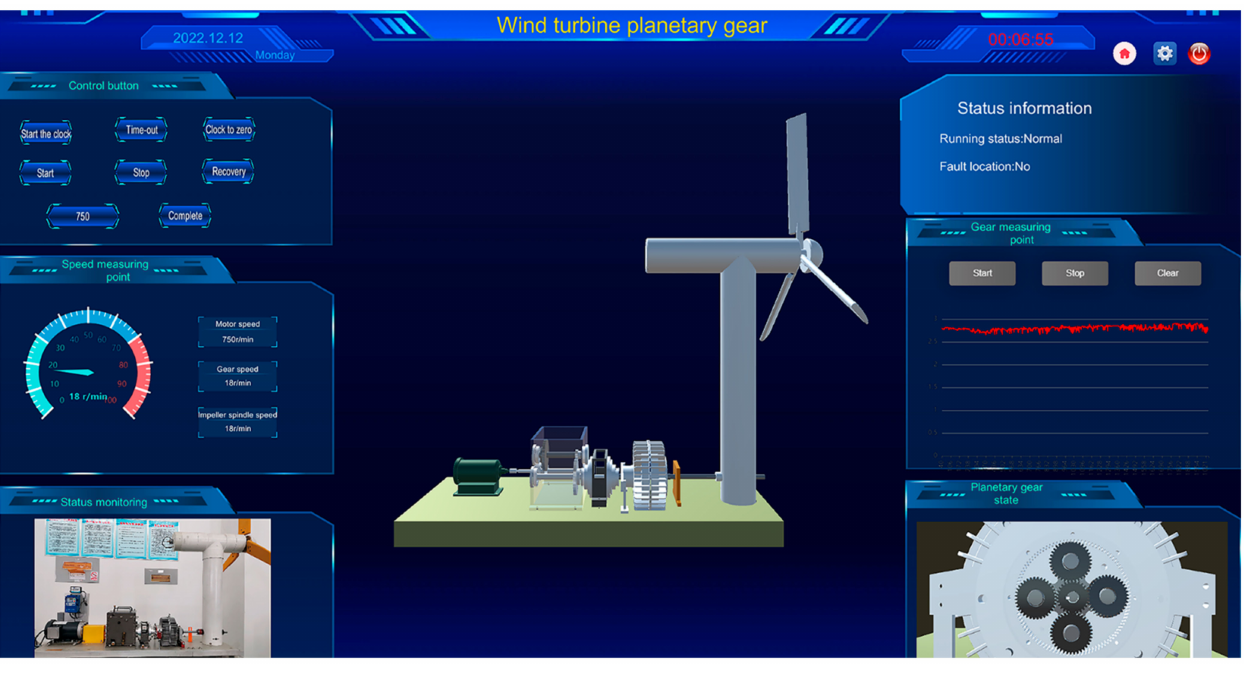
Figure 14. Digital twin system diagram.